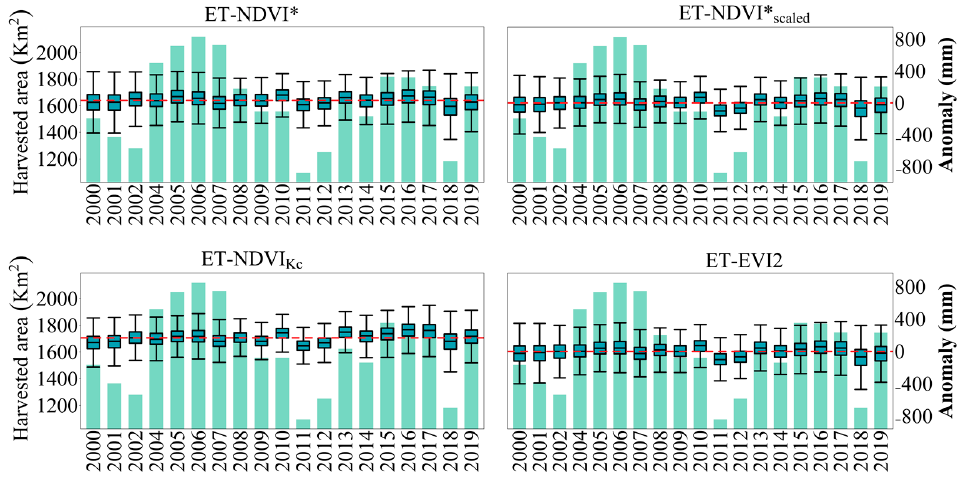
Figure 8. Annual harvested areas change (green bar chart) vs. annual ET-VIs’ anomaly (boxplots) over harvested areas.